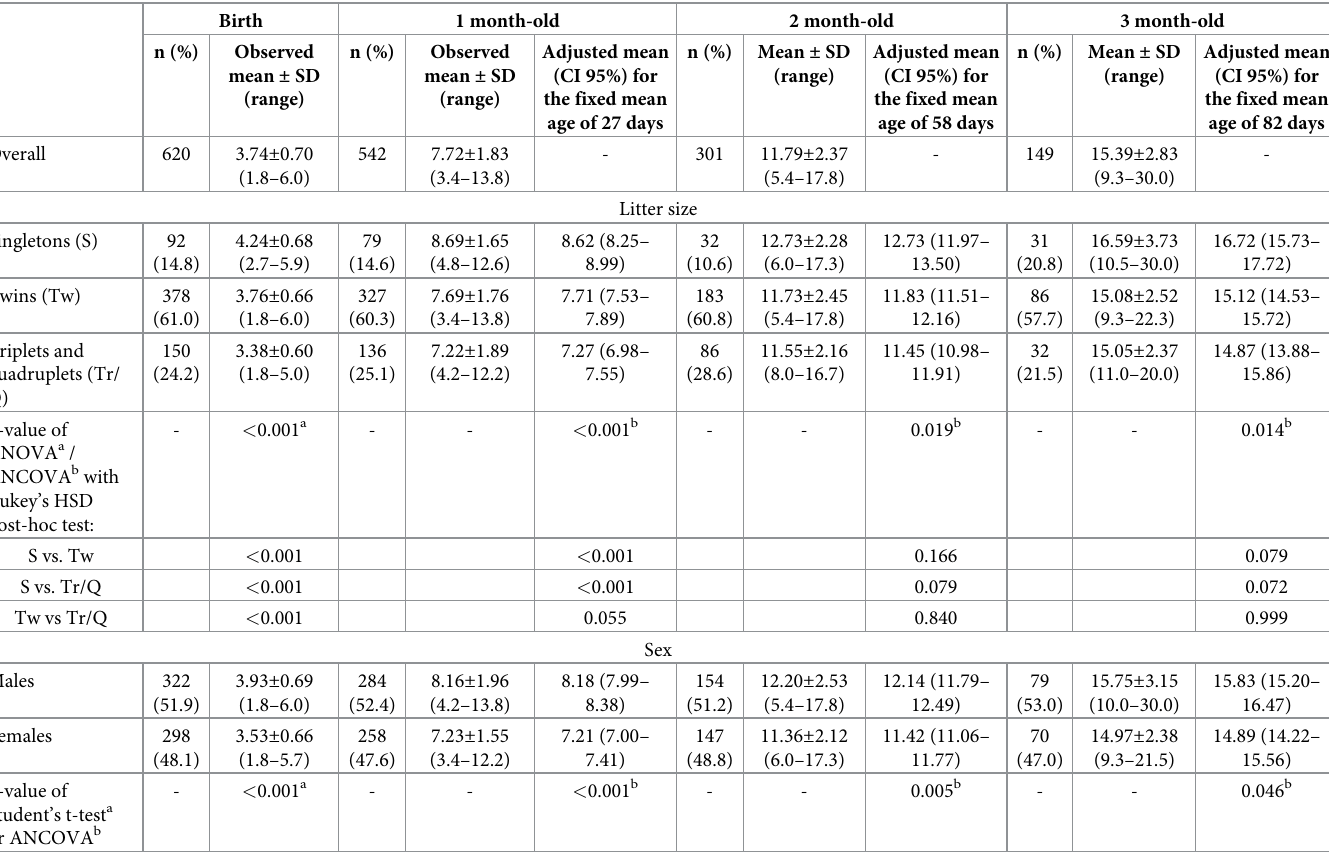
Table 2. General characteristics of body weight of kids (BWT) in three different time points—Observed and adjusted by the exact age at which a kid was